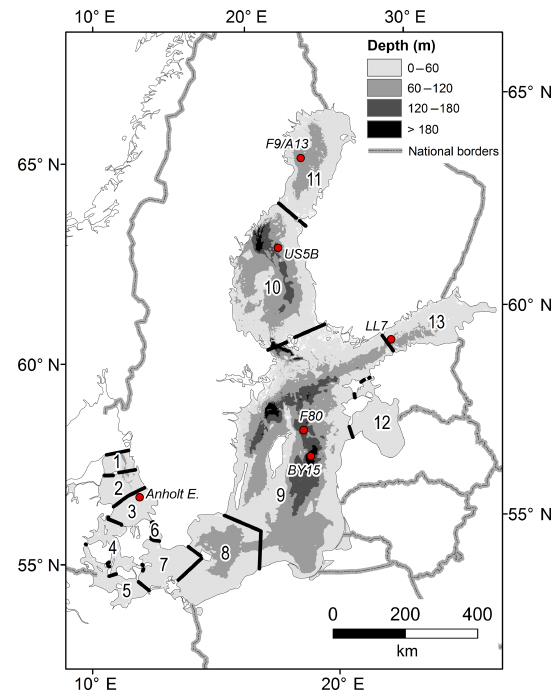
Figure 1. The Baltic Sea area with sub-basins and monitoring sta- tions. The sub-basins are (1) northern Kattegat (NK), (2) central Kattegat (CK), (3) southern Kattegat (SK), (4) Samsø Belt (SB), (5) Fehmarn Belt (FB), (6) Öresund (OS), (7) Arkona Basin (AR), (8) Bornholm Basin (BN), (9) Gotland Sea (GS), (10) Bothnian Sea (BS), (11) Bothnian Bay (BB), (12) Gulf of Riga (GR), and (13) Gulf of Finland (GF). Some BALTSEM sub-basins are ag- gregated into larger units in the budget calculations: the Kattegat (KT) includes sub-basins 1–3, the Danish Straits (DS) includes sub- basins 4–6, the Baltic Proper (BP) includes sub-basins 7–9, and the entire Baltic Sea (EBS) includes all